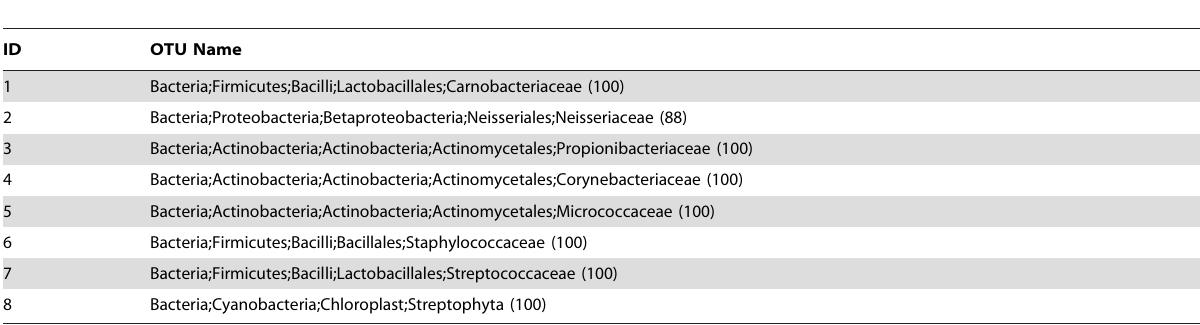
Table 3. Identified OTUs for keyboard data.